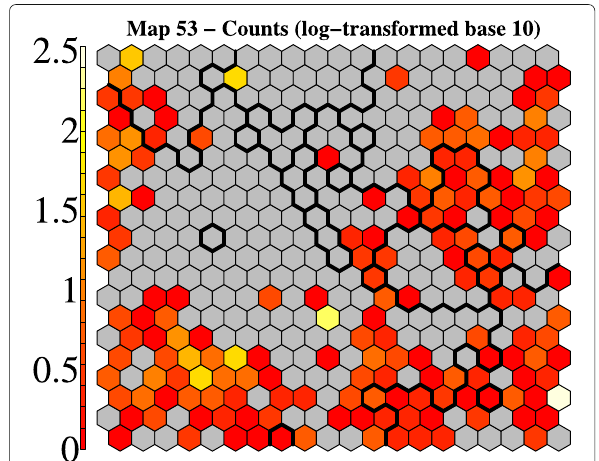
Fig. 11 Low Fuel Consumption Trip mapped to SOM. Notation similar to Fig.